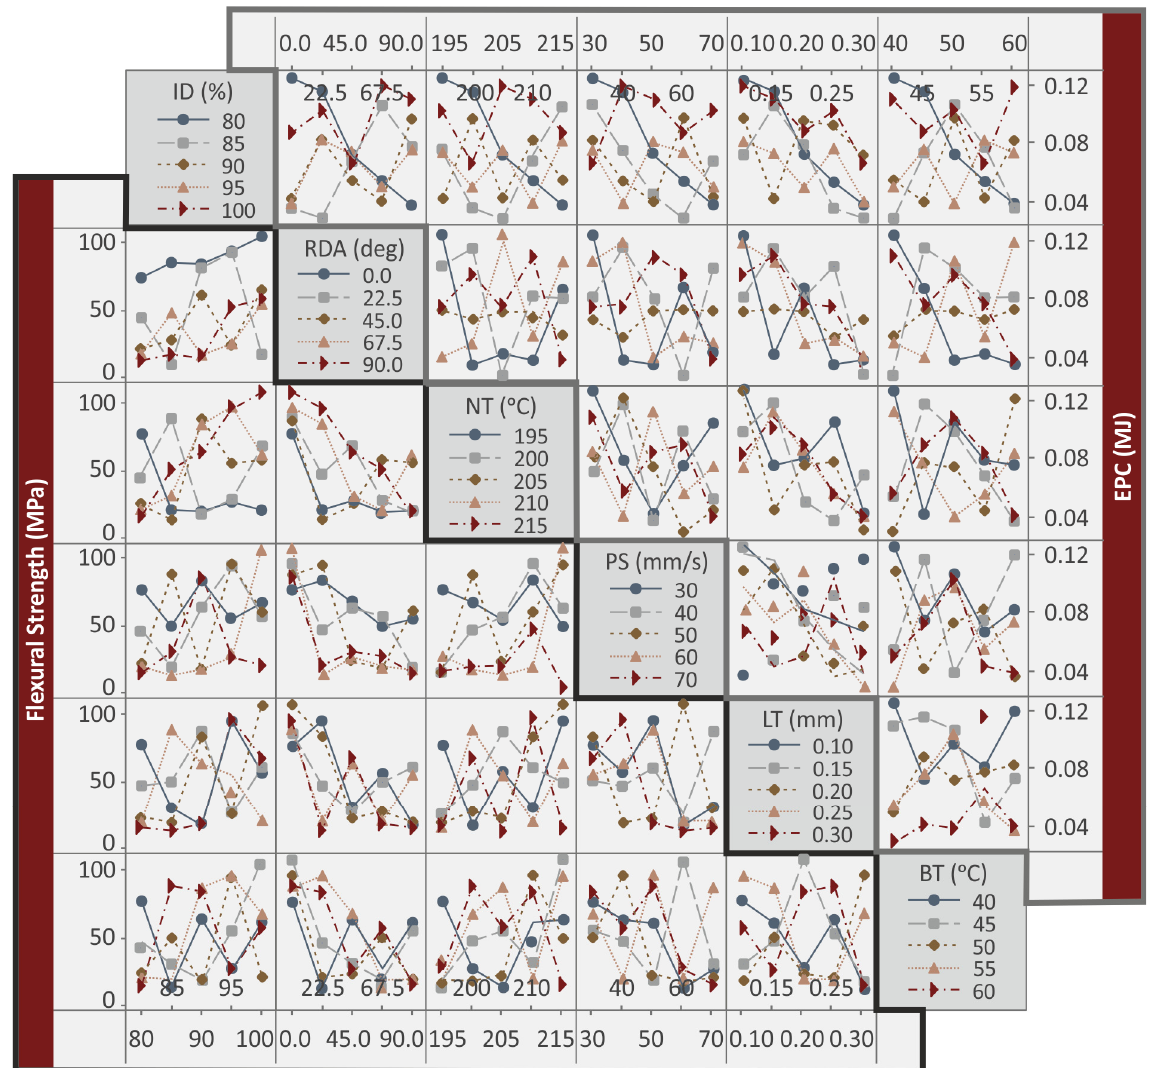
Figure 8. MEP: flexural strength (MPa), EPC (MJ).